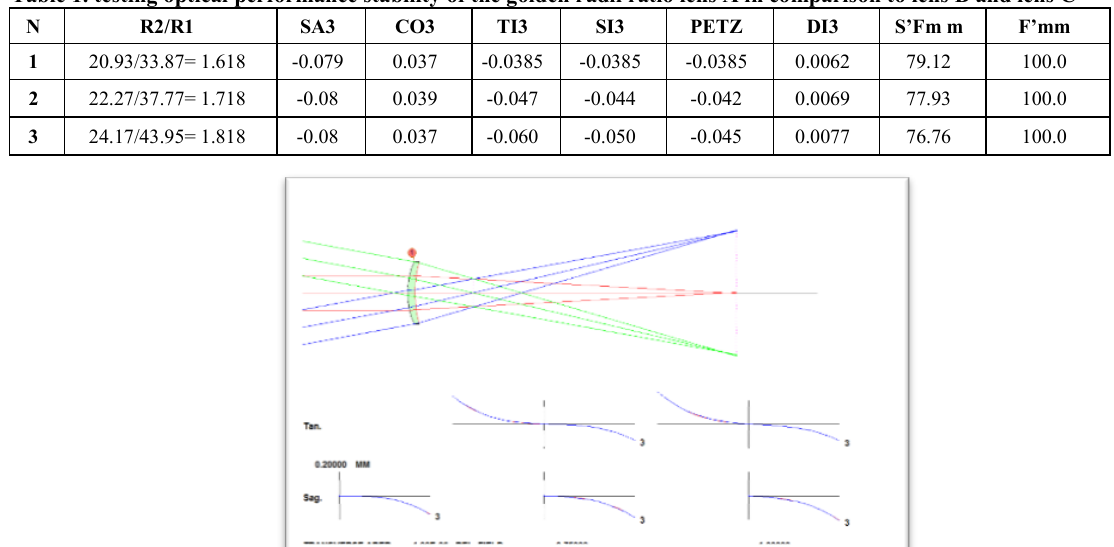
Table 1. testing optical performance stability of the golden radii ratio lens A in comparison to lens B and lens C